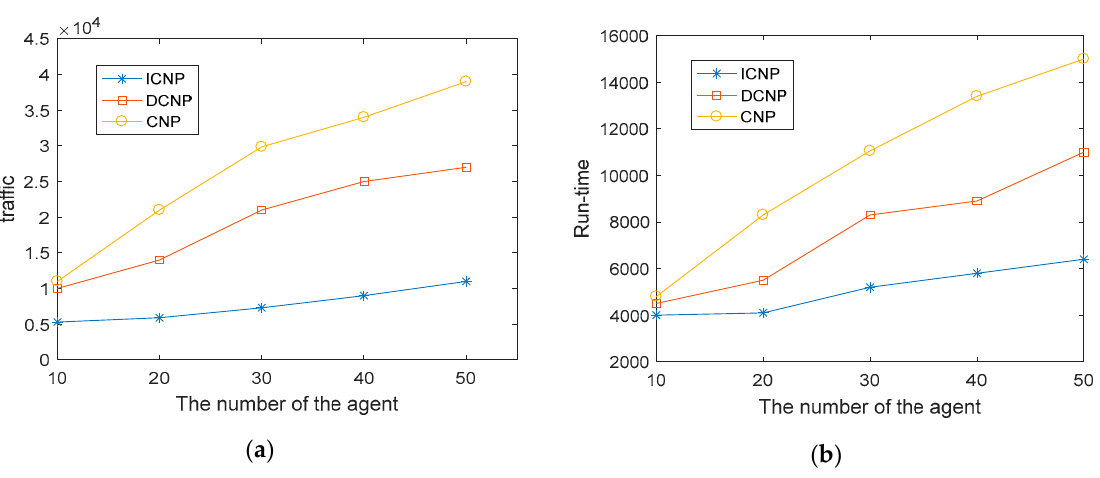
Figure 6. Comparative analysis of the three algorithms with different agent numbers. ( a ) The traffic of the improved contract net protocol with a different number of tasks; ( b ) The run-time of the improved contract net protocol with a different number of tasks.